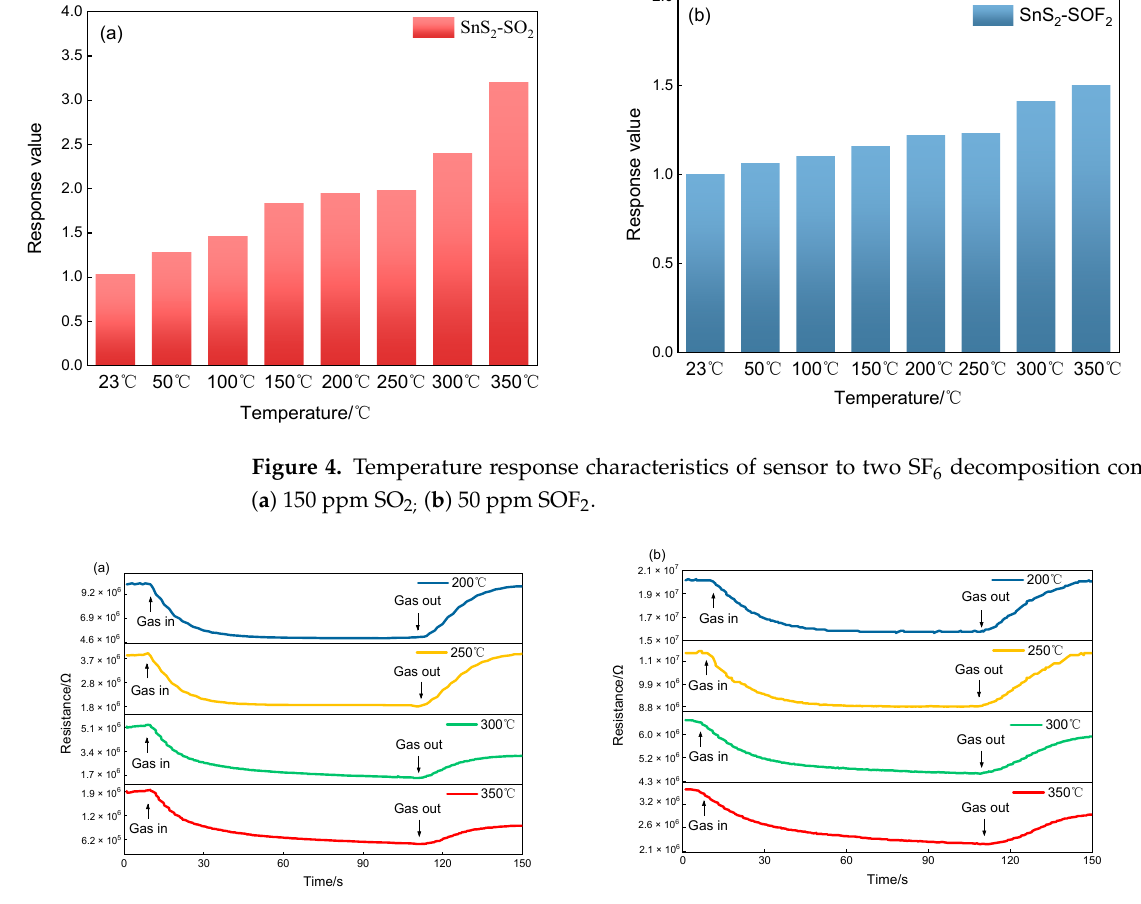
Figure 5. Recovery characteristics of the sensor to two SF 6 decomposition components: ( a ) 150 ppm SO 2; ( b ) 50 ppm SOF 2 .